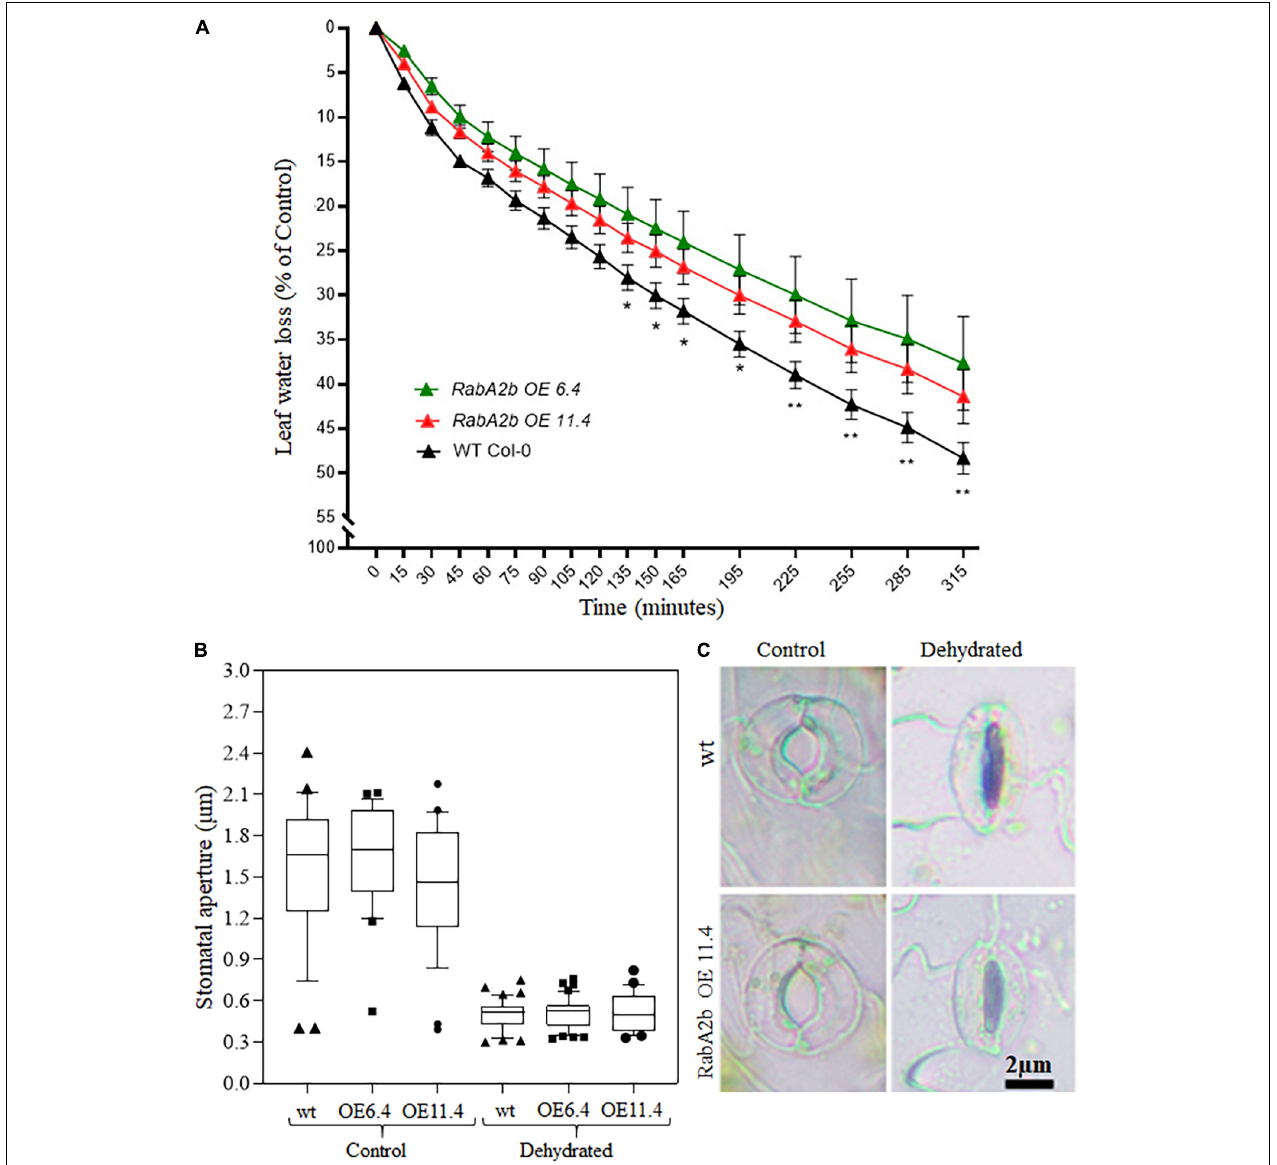
FIGURE 5 | Water loss and stomatal measurements in detached leaves of WT and RabA2b over-expressing lines. (A) Water loss measurements in detached leaves of wild-type and transgenic plants. Rosette leaves were detached from well irrigated 8 week -old plants and placed on laboratory bench for up to 315 min. Fresh weight Loss was monitored as a function of time, as described in the Section “Materials and Methods.” Shown is a representative triplicate experiment ( n = 5 leaves from five individual plants ± SE). Two-way ANOVA with Uncorrected Fisher’s LSD multiple comparison post-test, was performed to compare percentage change in initial weight of WT vs. Rab OE 6.4 or WT vs. Rab OE 11.4 at the said time interval. Only significant differences are displayed (* p < 0.05 and ** p < 0.006). (B) Box plot for stomatal aperture measurements in detached leaves of WT and RabA2b OE lines just after detaching (control) and 120 min after leaf detachment (dehydrated). Dark horizontal lines within the box represent the median, the box representing the 10th and 90th percentiles, the whiskers of 1.5 interquartile range (IQR) limits and outliers are represented by dots/squares/triangles ( n > 45). (C) Representative images of Stomata measured in (B) . Micrograph were captured as described in Section “Materials and